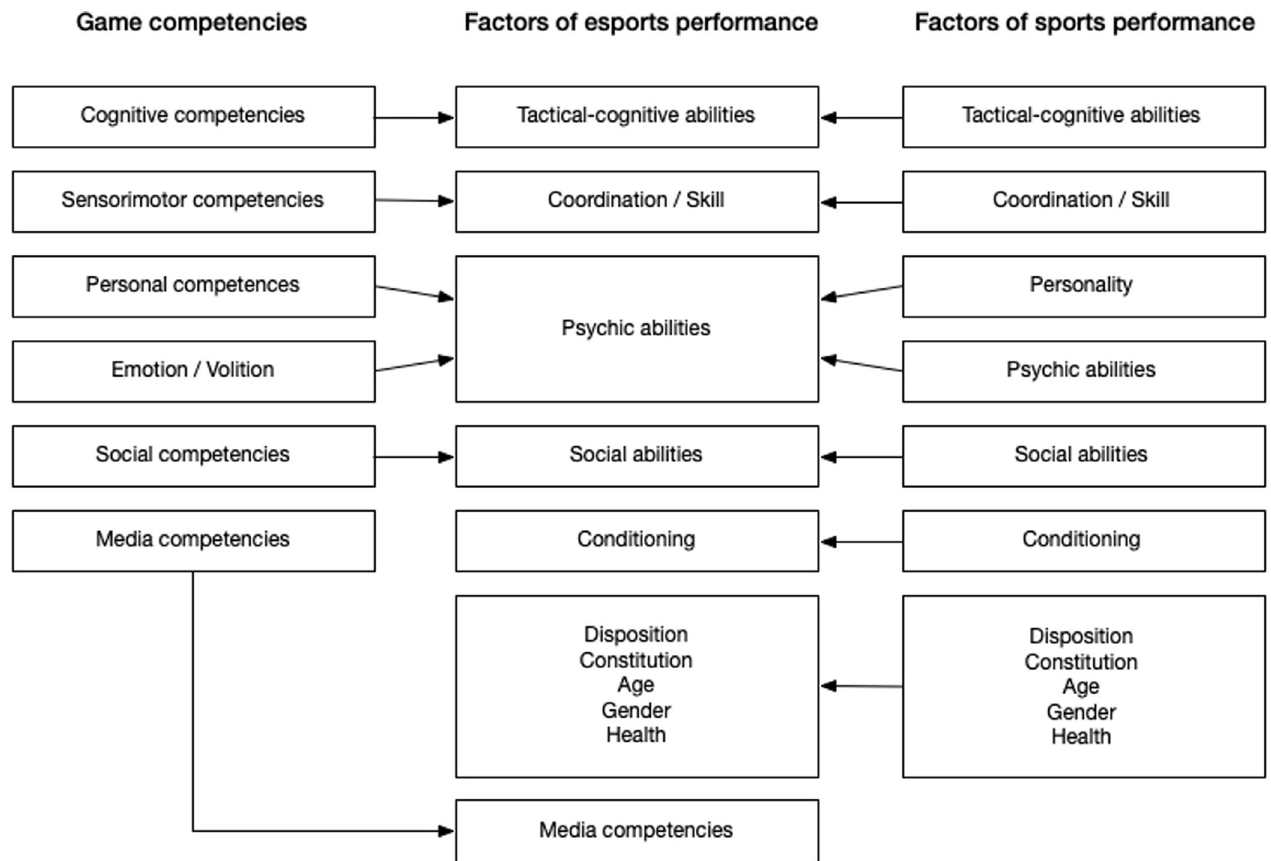
Fig 4. Integrative model of esports performance.